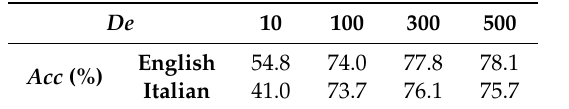
Table 7. Testing accuracy obtained by di ff erent embedding dimensions 1 .